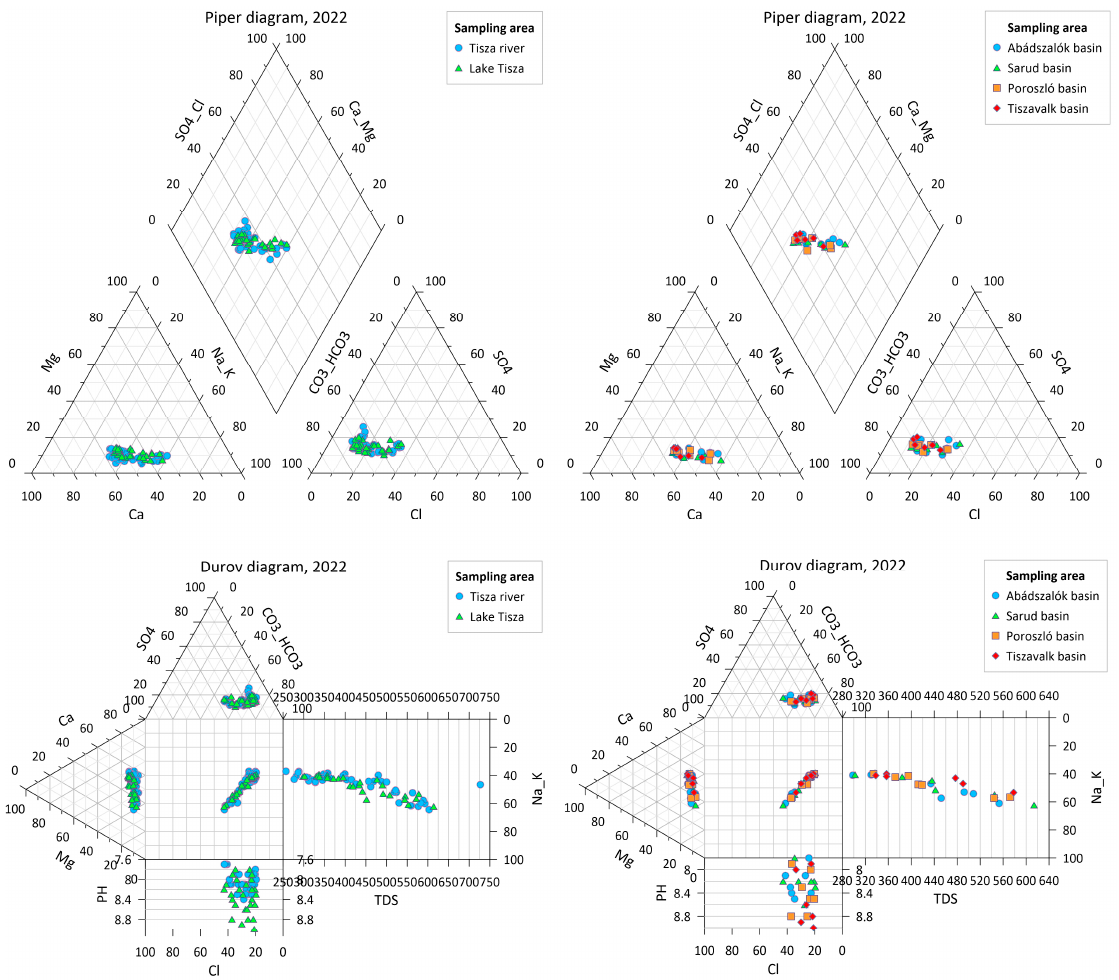
Figure 6. Hydrochemical faces of the sampling sites based on Piper and Durov diagrams.